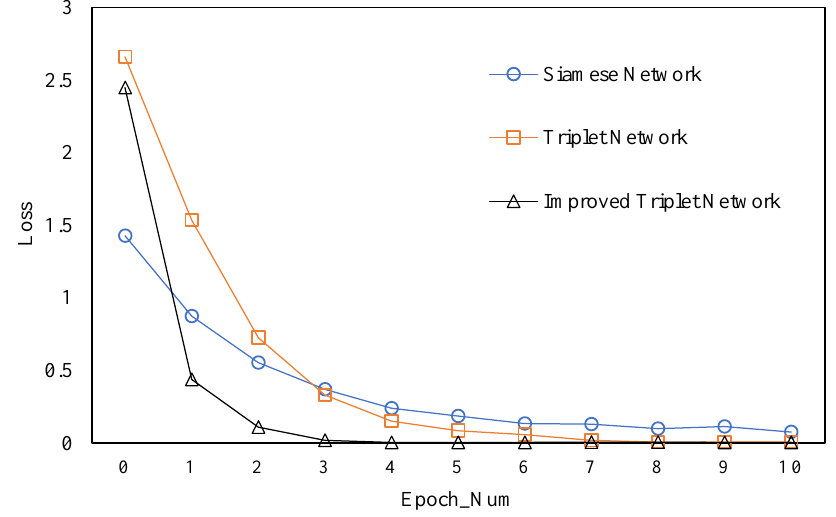
Figure 8. The convergence rate of the loss function varies with the epoch number.